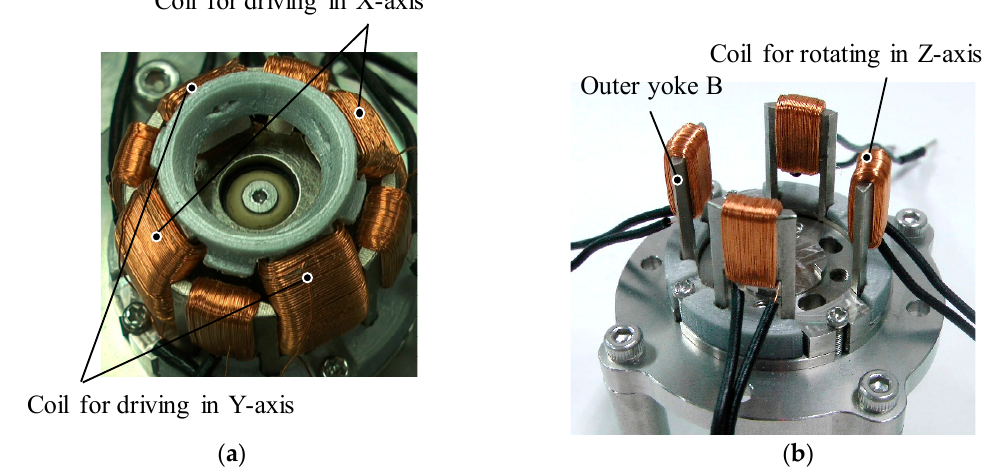
Figure 7. Coil structure. ( a ) Whole view without the support parts for the outer Yoke B; ( b ) Outer Yoke B and the coil for rotating in the Z -axis.